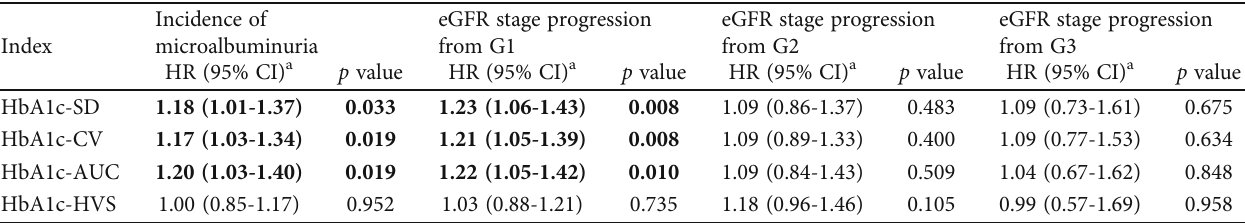
Table 3: Association of the risk of microalbuminuria and eGFR stage progression with continuous variables of visit-to-visit variability of HbA1c, measured as 4 indices using a Cox proportional hazards model.